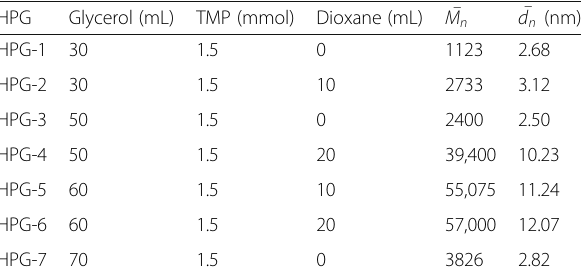
Table 1 Molecular weights and average particle sizes of HPG samples